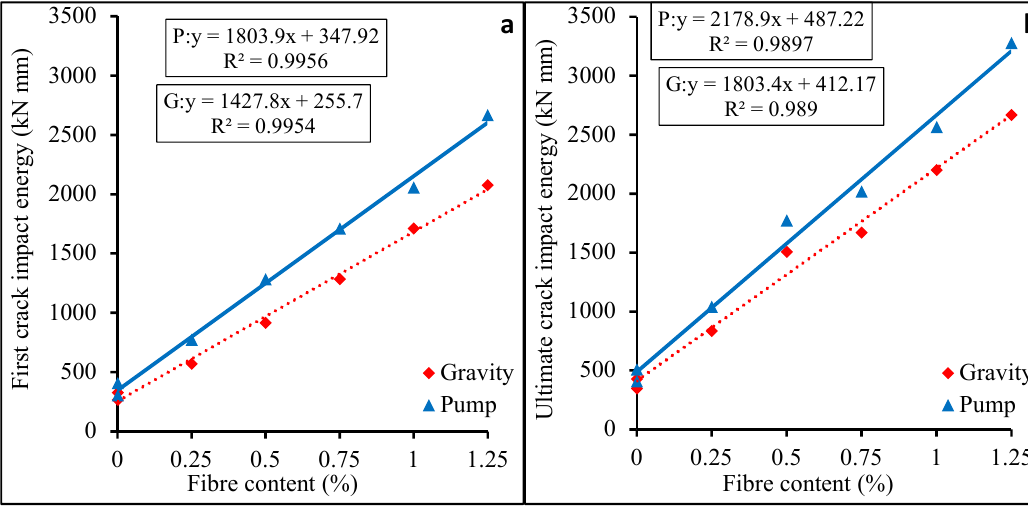
Figure 16. ( a ) The first and ( b ) ultimate crack impact energy vs. fibre content of PAFRC specimens.